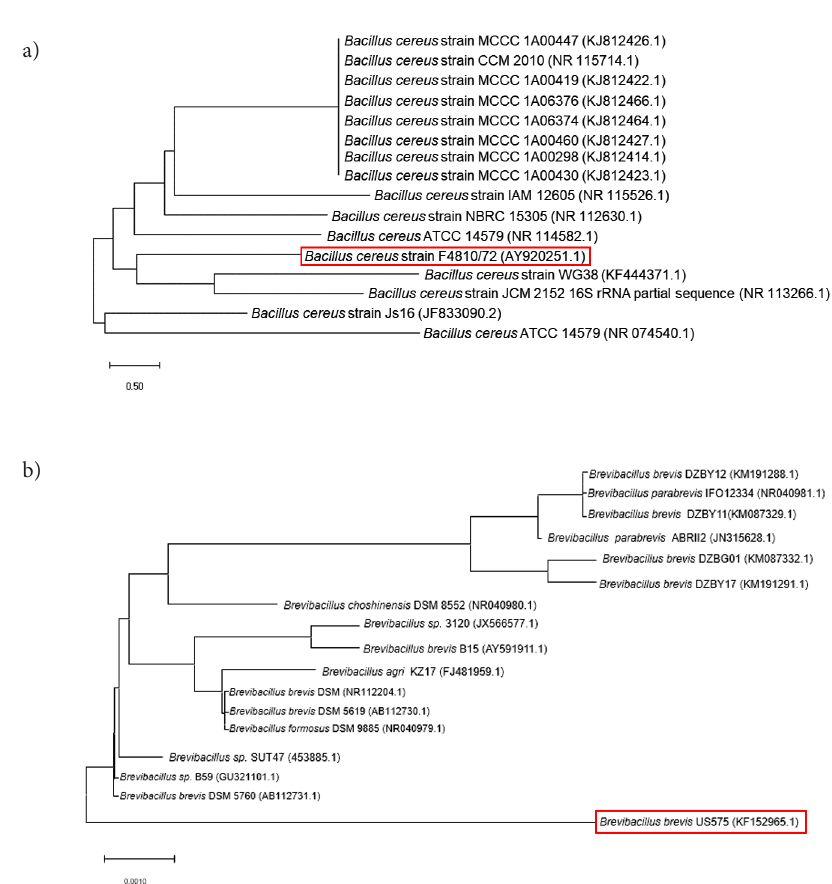
Figure 7. Phylogenetic tree obtained after sequence alignment of (a) Isolate 1, and (b) Isolate 4 by BLAST. A Phylogenetic tree was constructed through Neighbour Joining (NJ) method after aligning the partial sequence of 16S ribosomal RNA gene in Mega 7.0 keeping parameters default and Bootstrap value 1000. The Isolates 1 and 4 were identified as Bacillus cereus F4810/72 and Brevibacillus brevis US575 respectively and they were indicated and highlighted in a